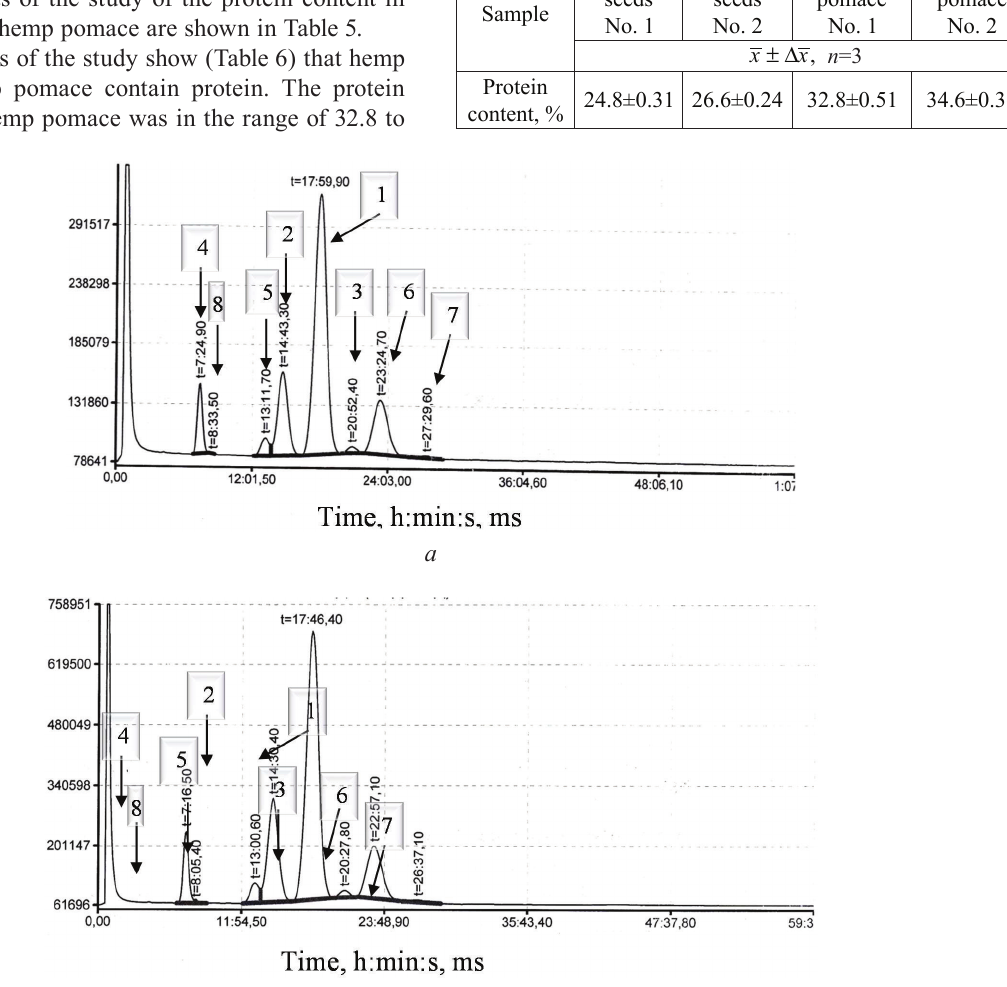
The protein content in Cannabis sativa L. raw materials